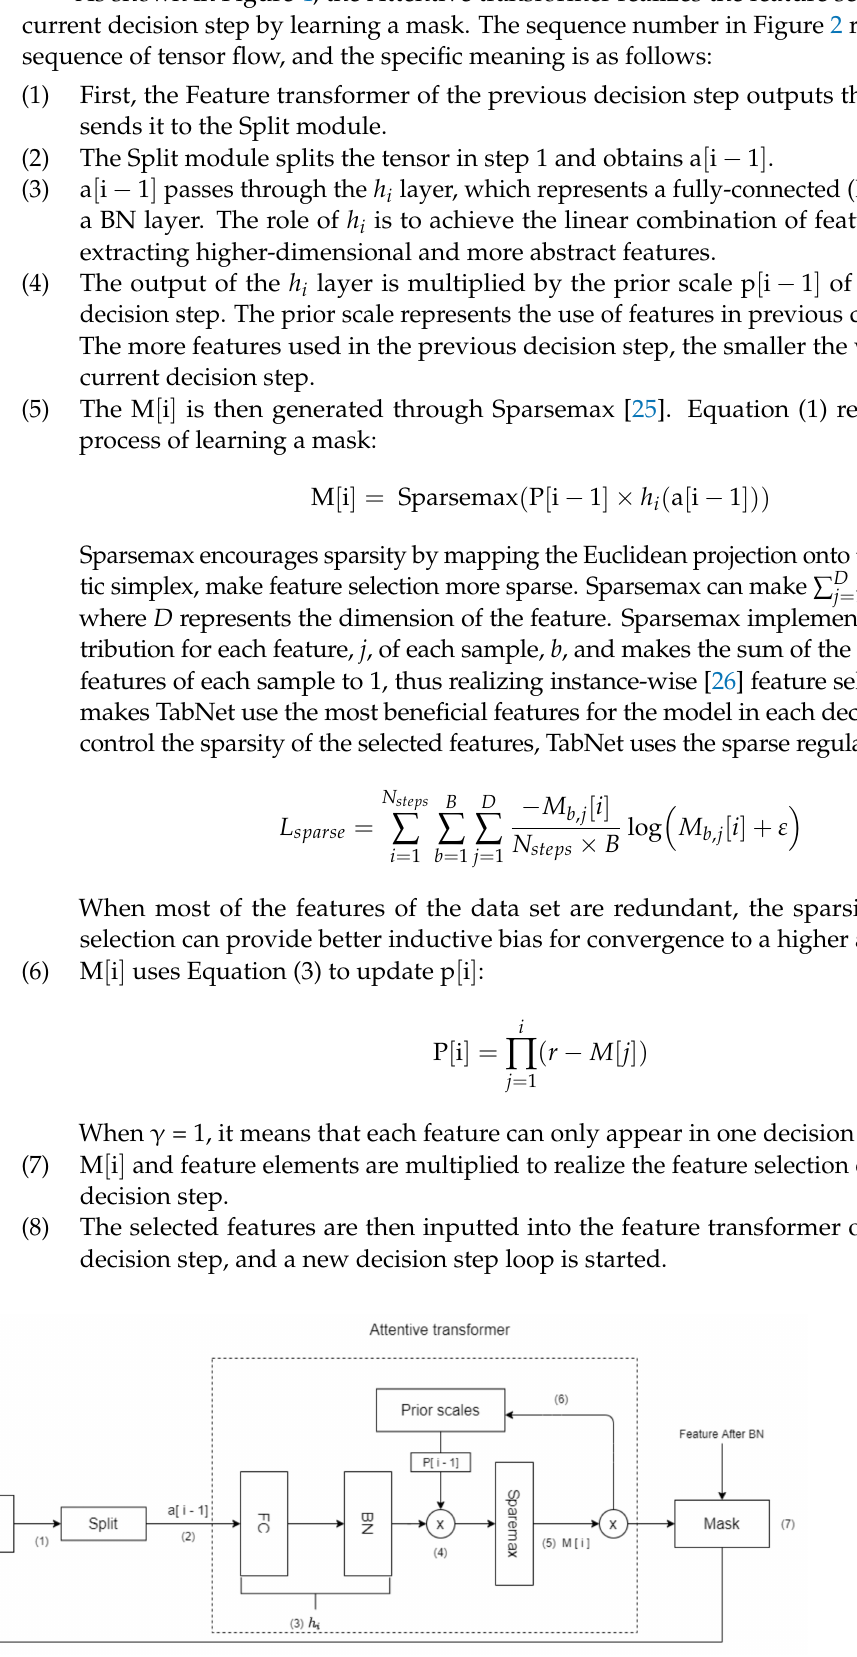
Figure 4. The topological structure of the Attentive transformer